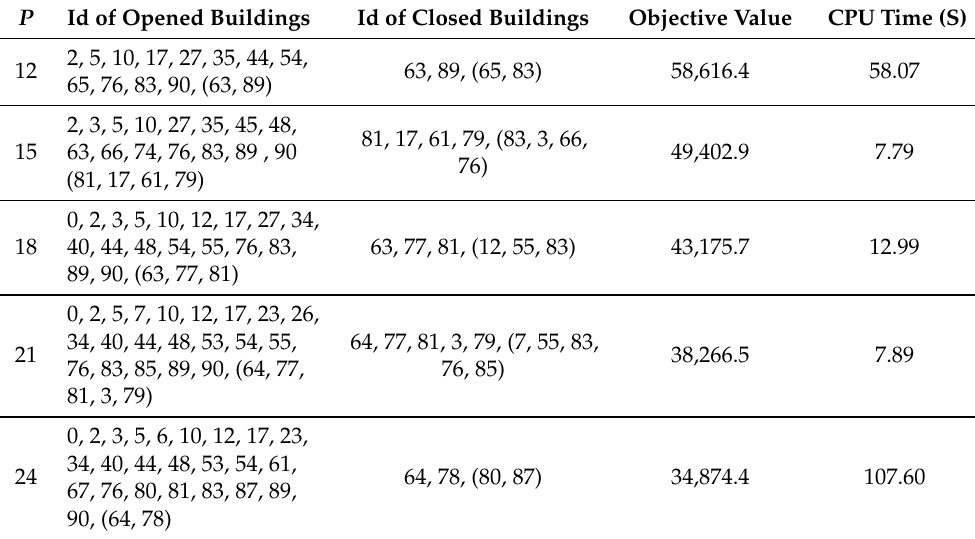
Figure 5. The impact of the number of facilities on the objective functions and CPU process time. Table 13. Sensitivity Analysis on Parameter P